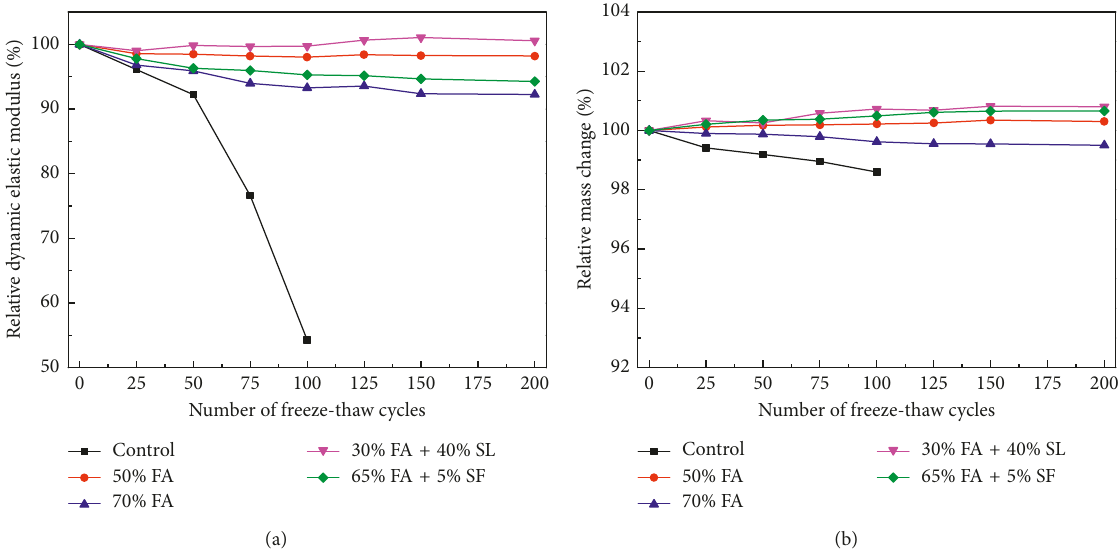
Figure 2: (a) Relative dynamic elastic modulus. (b) Relative mass change versus under freeze-thaw cycles in tap water.